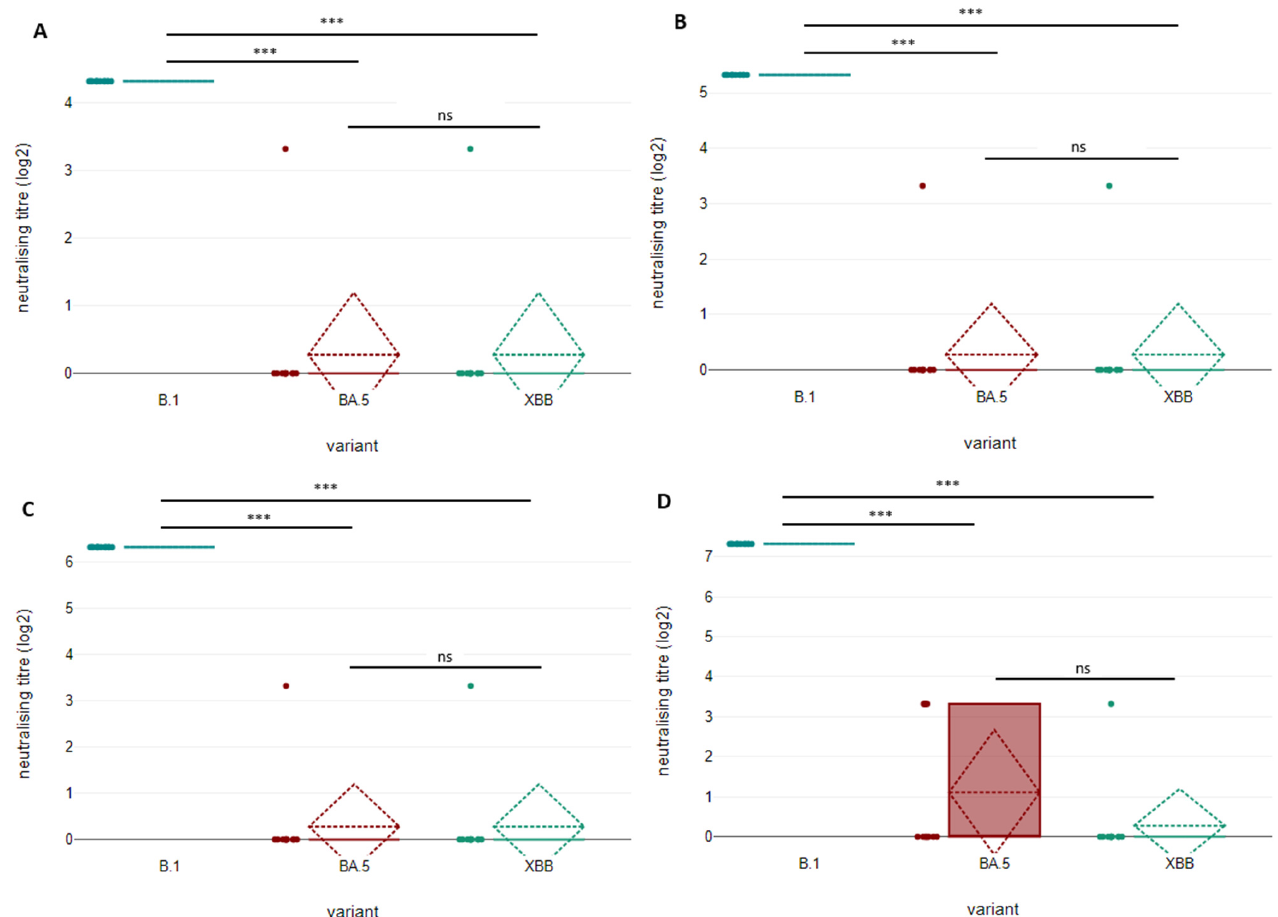
Figure 1. Comparison of neutralising antibody titres of low (titres 20 and 40) and medium (titres 80 and 160) neutralising sera against SARS-CoV-2 original strain B.1, lineage B.1.1.529 BA.5 and recombinant XBB at four weeks after the second dose of BNT162b2 vaccine. Sera were grouped depending on the neutralisation titre against ancestral lineage B.1 and retested with lineage BA.5 and recombinant XBB. For each group, 12 sera were tested ( n = 12). Results for sera with a neutralisation titre of 20, 40, 80 and 160 are shown in panels ( A ), ( B ), ( C ) and ( D ), respectively. Neutralisation titre is expressed as the reciprocal of the highest serum dilution capable of inhibiting the appearance of a visible cytopathic effect. The detection limit of the assay is defined as a titre of 10; sera which did not reach the detection limit were considered negative and their titre was approximated to zero. The upper limit of detection is defined as a titre of 5120. Statistical comparison of neutralisation titres against the three considered viral variants were compared using a one-way repeated-measures ANOVA test (*** p < 0.01, ns = not significant). Medians are indicated with solid horizontal lines, means with dashed horizontal lines and standard deviations with dashed oblique lines.